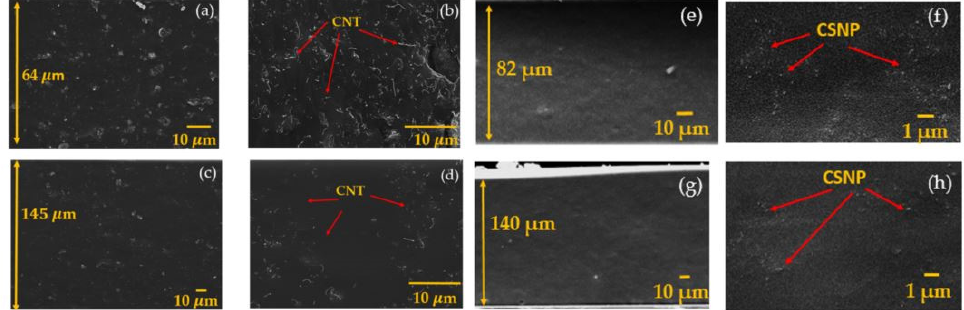
Figure 2. Scanning electron microscopic images of CNT-PDMS and CSNP-PDMS composite films (p20 and p40). ( a – d ) Cross-sectional and its enlarged views for CNT p20 in ( a , b ) and CNT p40 in ( c , d ). ( e – h ) Similar images for CSNP p20 in ( e , f ) and CSNP p40 in ( g , h ). The images of CSNP-PDMS (p40) composite film were reproduced from [29].